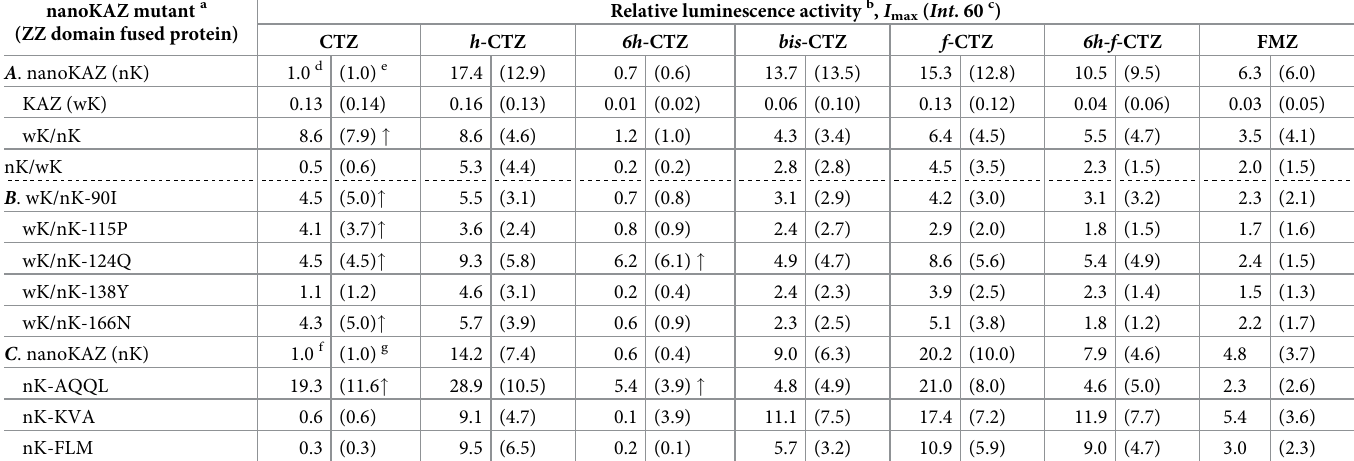
Table 1. Luminescence activities of chimeric proteins among wild KAZ, nanoKAZ, and their reverse mutants of nanoKAZ using coelenterazine (CTZ) and CTZ analogs as a substrate. nanoKAZ mutant a (ZZ domain fused protein)